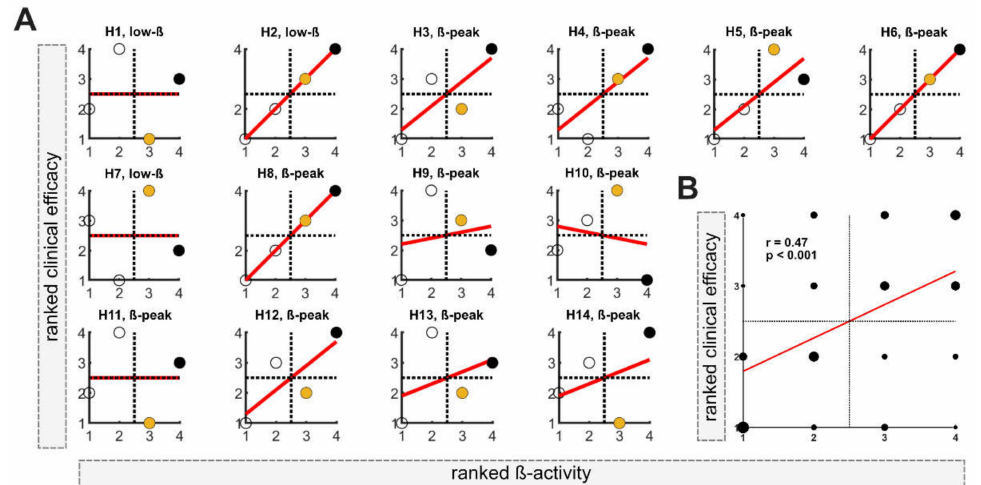
Figure 2. Determination of the best stimulation level: ( A ) Correlation between ranked clinical efficacy (improvement in UPDRS-III items 22, 23 and 25) and ranked ß-activity for each hemisphere (H1–H14). The filled black dots correspond to the level with the highest beta activity. The filled yellow dots correspond to the level with the second-highest beta activity. n per hemisphere = 4. #1 = the